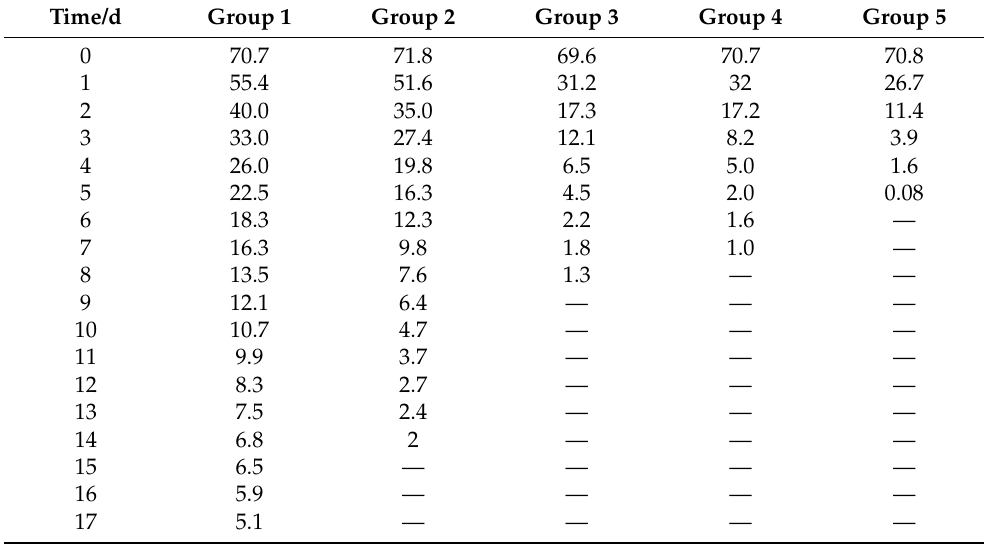
Table 3. Daily moisture content values of specimens of five groups